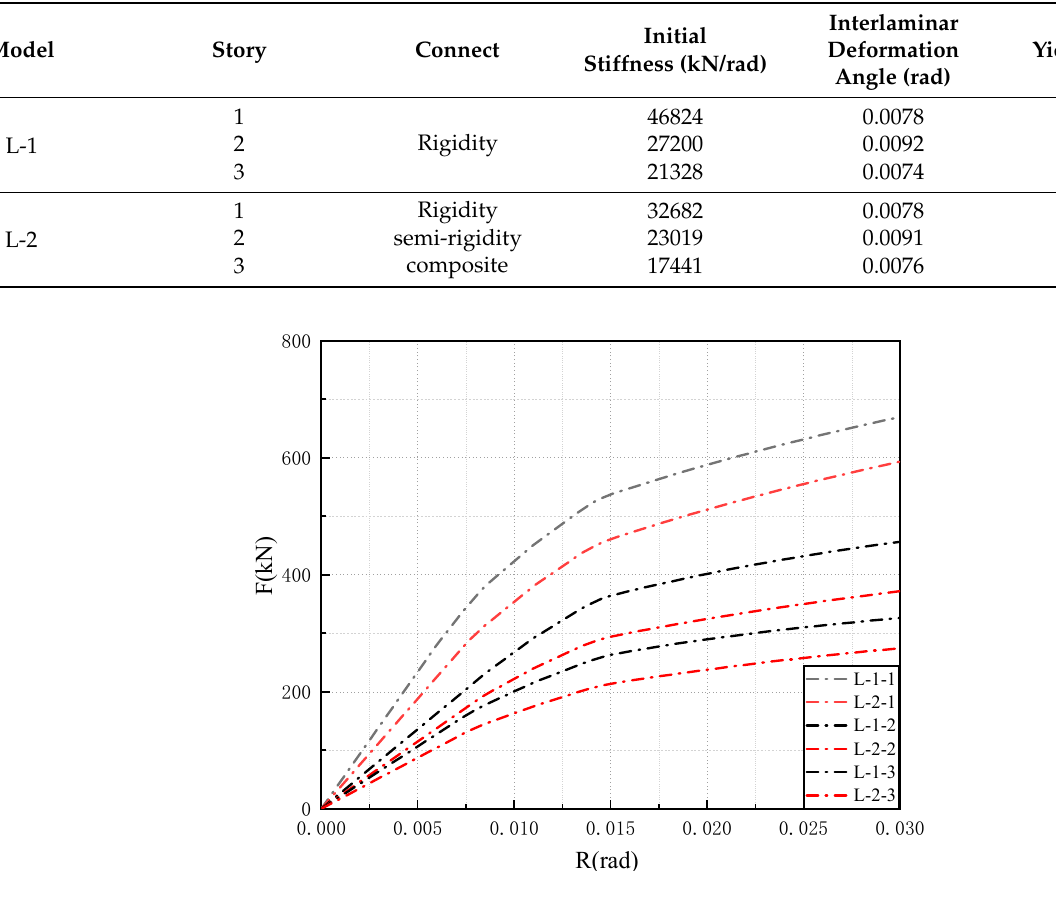
Figure 17. The load-displacement curves of model L-1 and L-2.